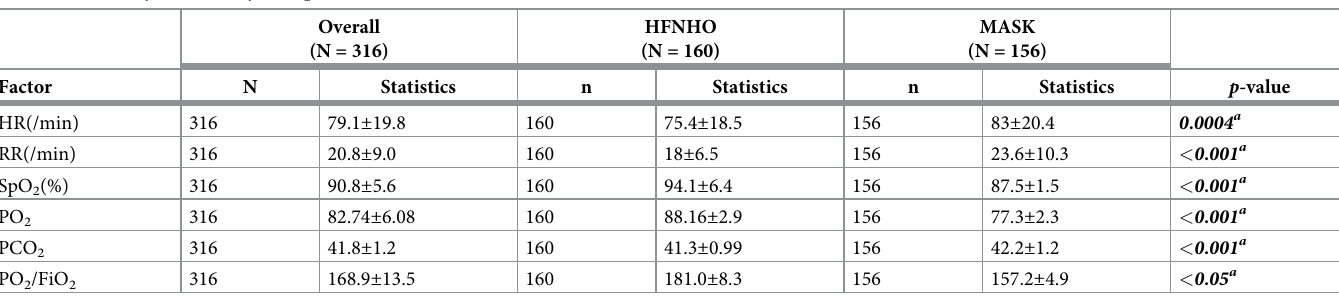
Table 2. Summary Statistics by Groups (HFNHO vs MASK).